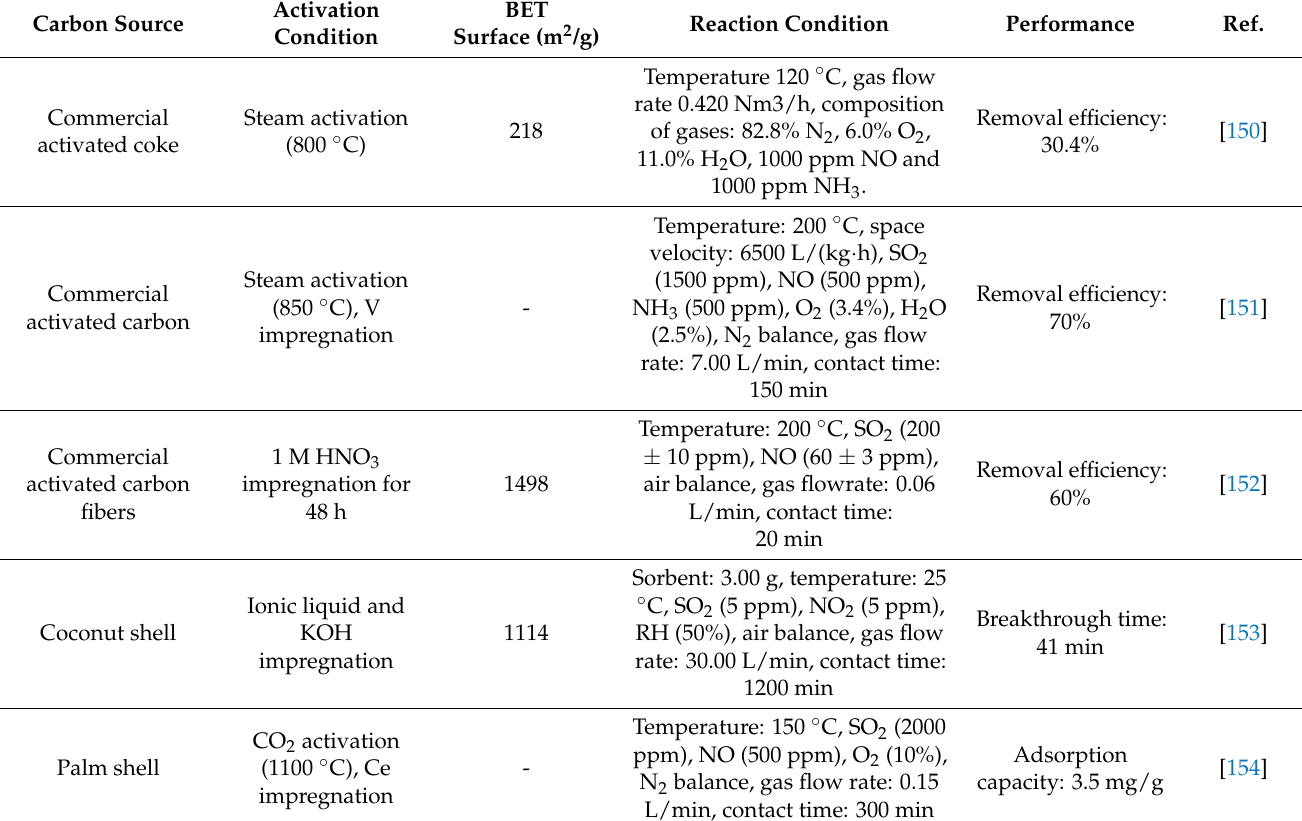
Table 6. Adsorption of NOx with activated carbons from different carbon